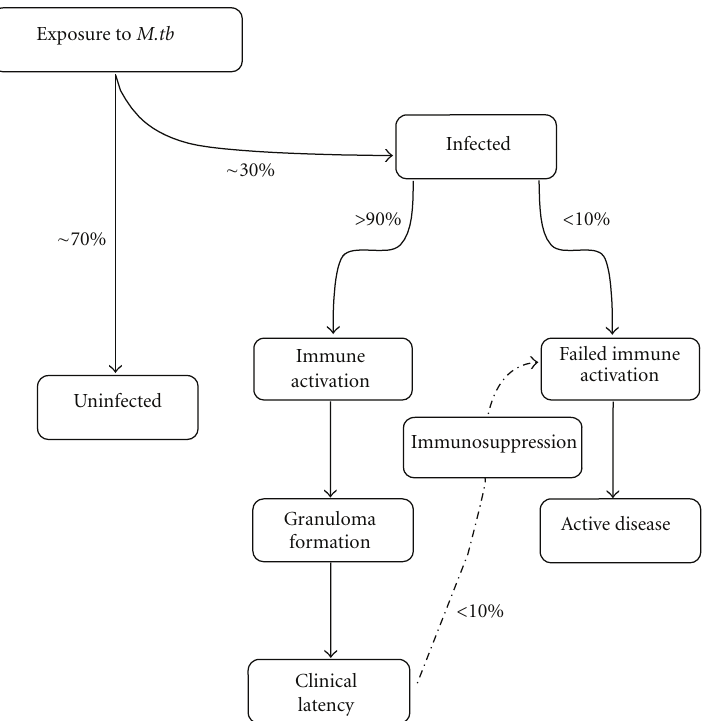
Figure 1: Flow chart of TB disease progression and major events leading to protection. Major steps are outlined for the progression of and infected or uninfected hosts from the point of exposure to development of active disease or clinical latency (protection). The relative percentage of individuals to progress between steps is shown beside the appropriate progression